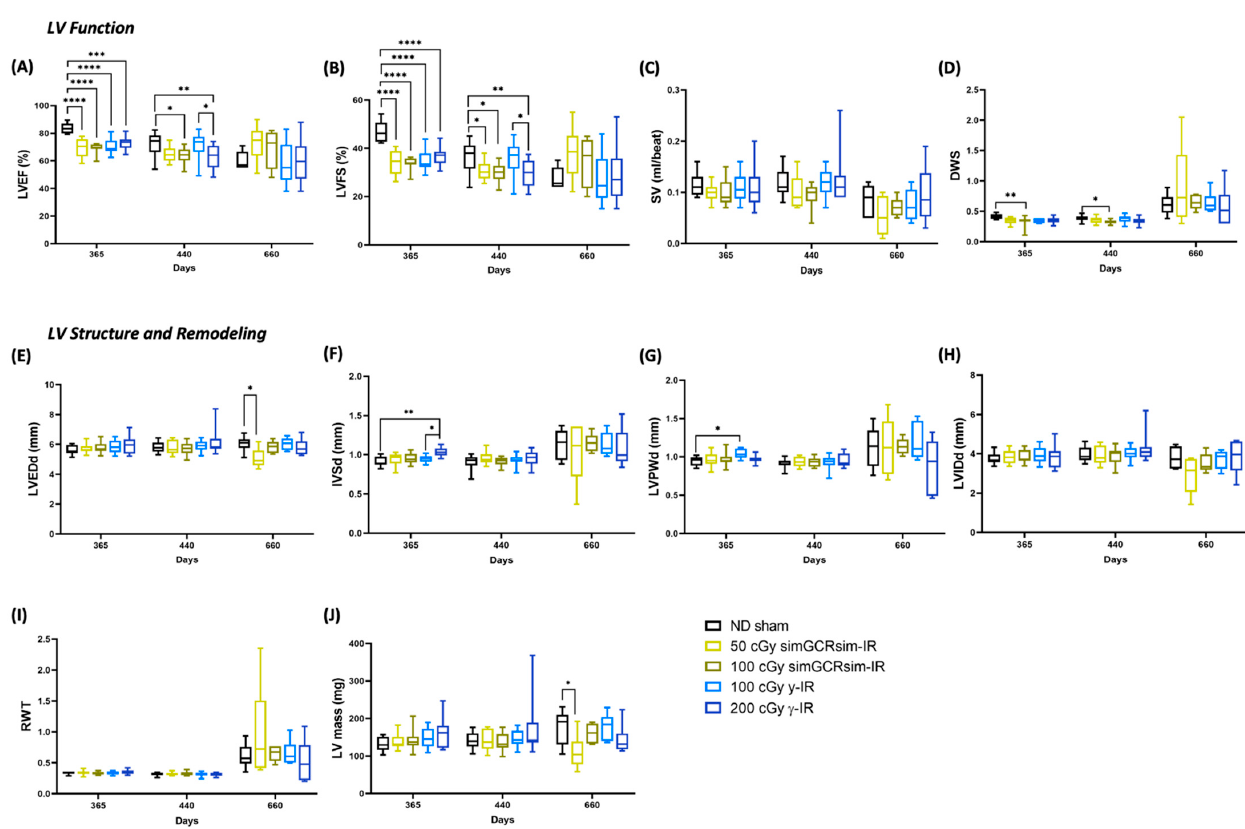
Figure 3. Longitudinal echocardiography results in C57BL/6J male mice at 365, 440, and 660 days after gamma ( γ ) and simGCRsim irradiation. Left ventricular (LV) function is represented by ( A ) ejection fraction, ( B ) fractional shortening, ( C ) stroke volume (SV), and ( D ) radial wall strain (DWS). Parameters of LV dimensions and remodeling are represented by ( E ) LV end diastolic diameter, ( F ) intraventricular septal thickness, ( G ) LV posterior wall thickness, ( H ) LV internal cavity diameter, ( I ) relative wall thickness, and ( J ) LV mass. n = 10–15 mice per treatment condition and time point; p-values were calculated using one-way ANOVA. **** p < 0.0001, ** p < 0.01, * p < 0.05. At 440 days, the global LV systolic function remained impaired in mice irradiated with either dose of simGCRsim-IR (Figure 3A,B). In 50 cGy simGCRsim-IR mice, LVFS was sig- nificantly reduced by ~6% (31% ± 1.1 vs. ND sham 37% ± 1.6, p < 0.04), and LVEF by 7% (65% ± 1.5 vs. ND sham 72% ± 2.1, approaching significance, p = 0.07) (Figure 3A,B). No changes